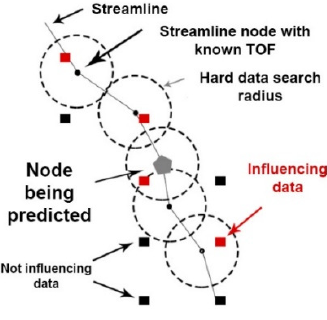
Figure 10. Time of flight assigned to hard data found along the streamline is used as a distance parameter for calculating the variogram, while influencing points are searched within given TOF distance from the streamline.